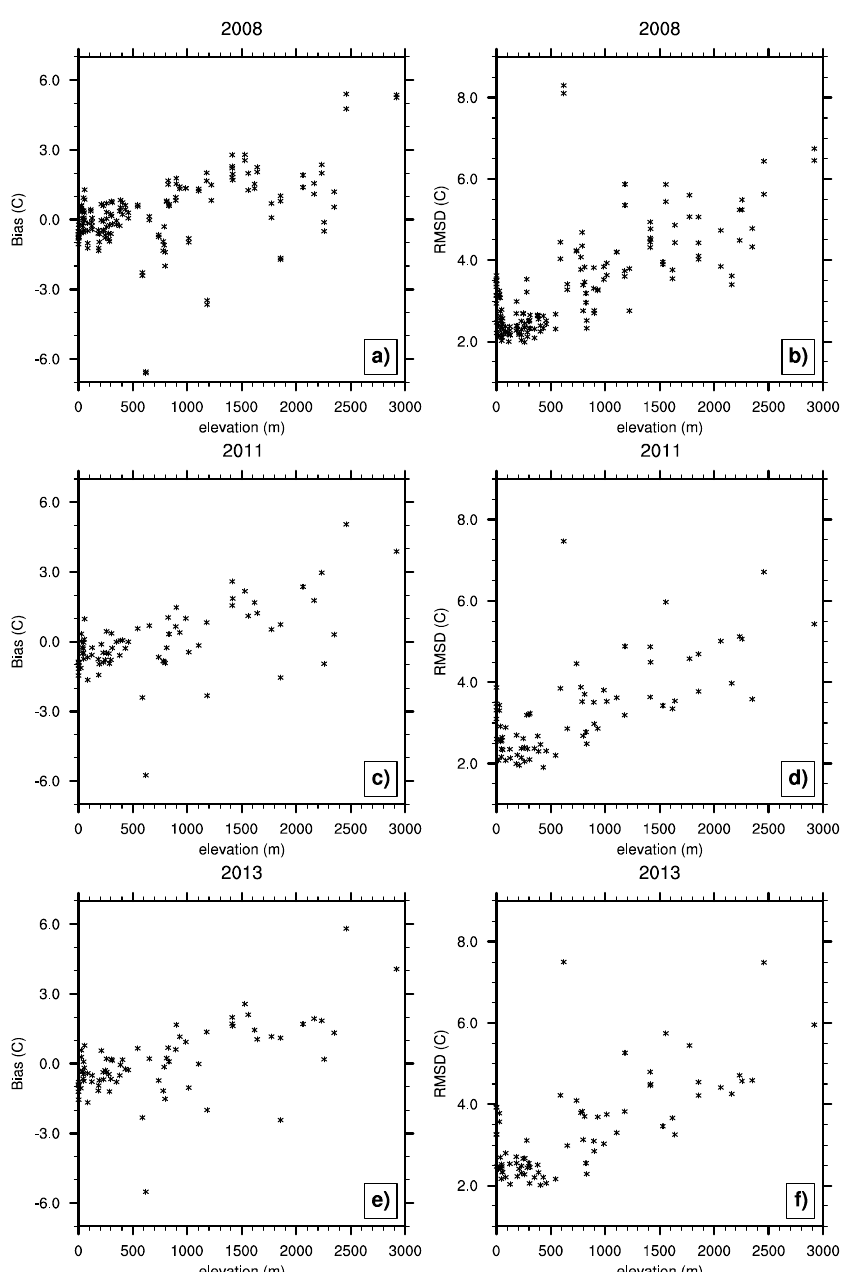
Figure 8. Scatter plots of annual mean bias and RMSD (°C) of HIRS SAT co-located to each USCRN station along elevation (m) for 2008, 2011, and 2013. The bias and RMSD values for the three years are plotted in ( a ) and ( b ) for 2008; in ( c ) and ( d ) for 2011; and in ( e ) and ( f ) for 2013, respectively.